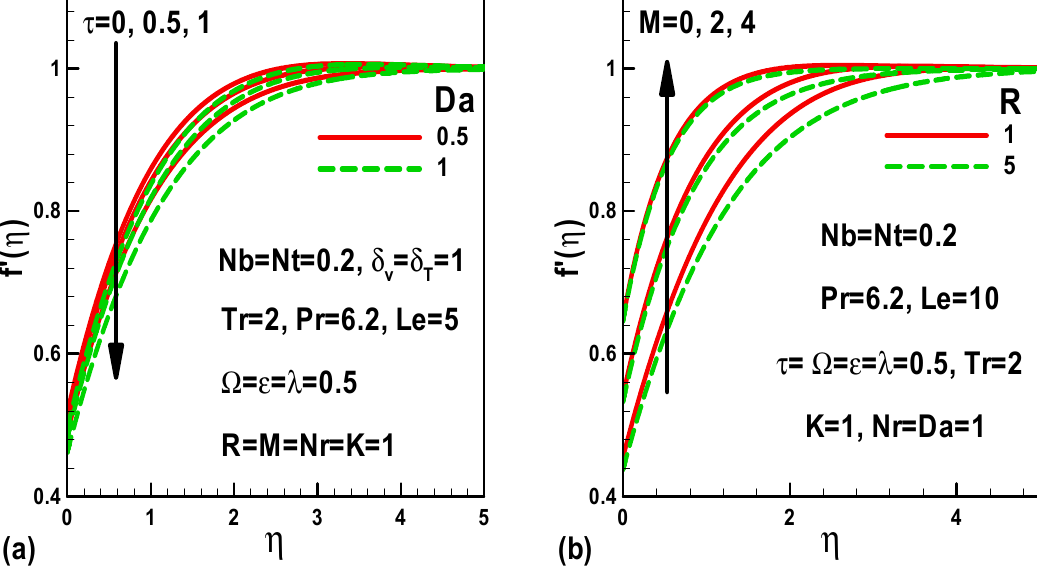
Figure 4. Variation of dimensionless velocity with (a) Darcy number and dimensionless time and (b) with magnetic and radiation parameters.